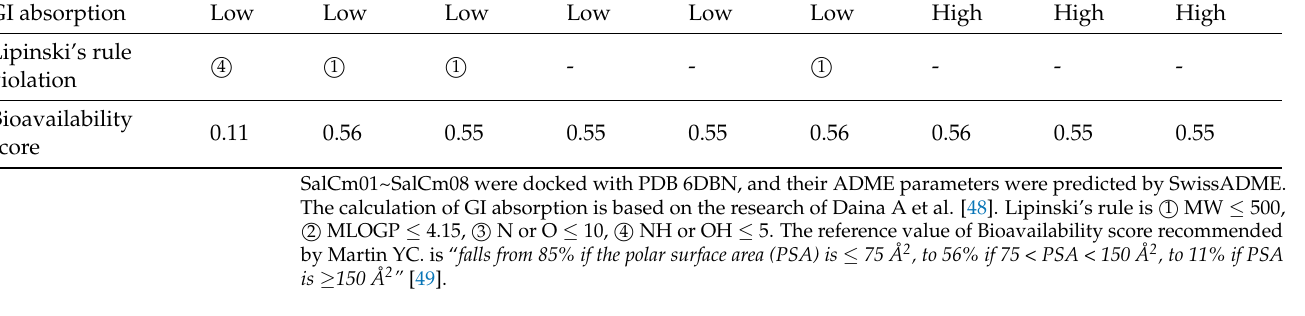
Table 4. ADME parameters and binding scores (to JAK) for compounds ( a )~( h ) in Figure 7.